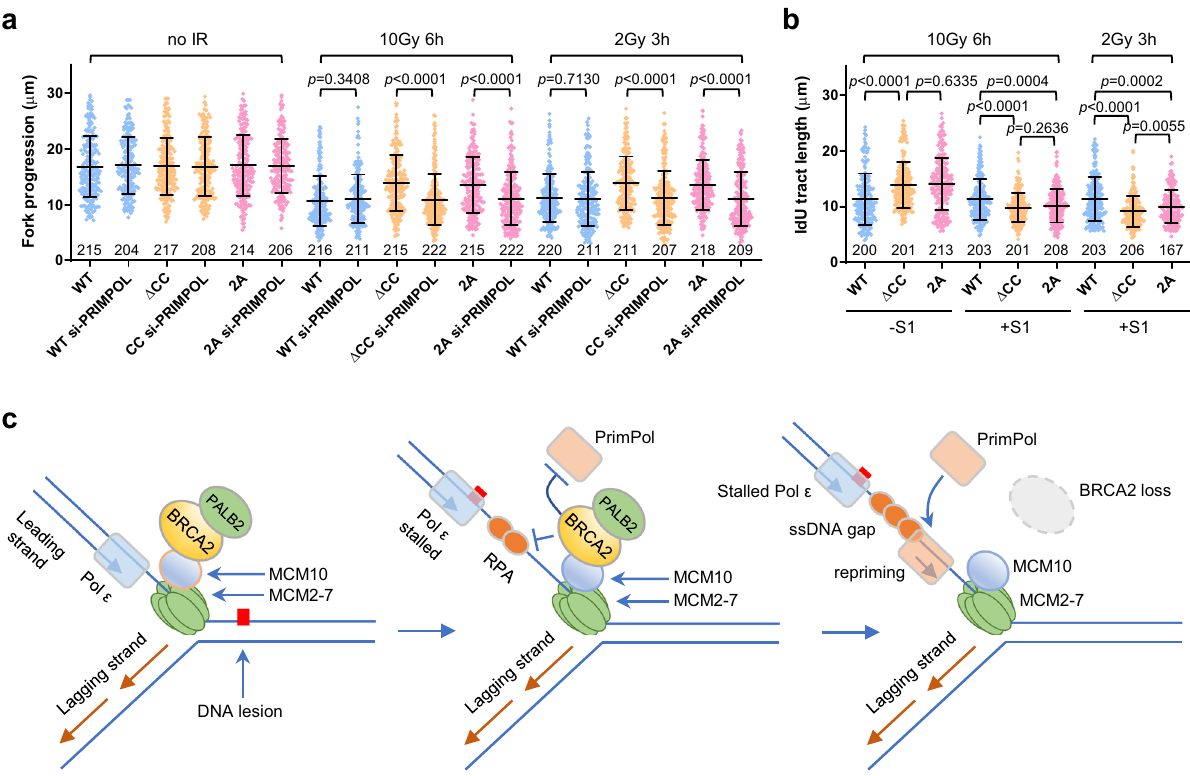
Fig. 6 The BRCA2 – MCM10 association suppresses PRIMPOL-mediated repriming and ssDNA gap formation after DNA damage. a Effect of PRIMPOL depletion on replication fork progression in stable U2OS cells selectively expressing exogenous WT vs Δ CC mutant MCM10 proteins before and after IR. The endogenous MCM10 was depleted together with PRIMPOL with siRNAs targeting the 3 ′ -UTR of its mRNA. b Effect of S1 nuclease treatment on detected replication tract length in the above cells after IR. Data in ( a ) and ( b ) are presented as mean ± s.d., with the number of dots shown below each column. P values are calculated using two-tailed unpaired Student ’ s t test. Similar results were obtained in n = 2 independent experiments. c A proposed model for the role of BRCA2 and the BRCA2 – MCM10 association in replication fork progression after DNA damage. BRCA2 is recruited to the replication fork via its association with MCM10. When the fork encounters a lesion, polymerase ε stalls, whereas the MCM2-7 helicase complex continues to unwind downstream DNA, leading to excessive ssDNA formation. RPA binds to the ssDNA and may recruit PRIMPOL; however, PRIMPOL recruitment is prevented by BRCA2, which can displace RPA from ssDNA. When BRCA2 is lost or the BRCA2 – MCM10 association is compromised, increased and/or persistent presence of RPA on ssDNA leads to PRIMPOL recruitment, hence repriming of DNA synthesis downstream of the lesion and formation of ssDNA gaps. See text for further